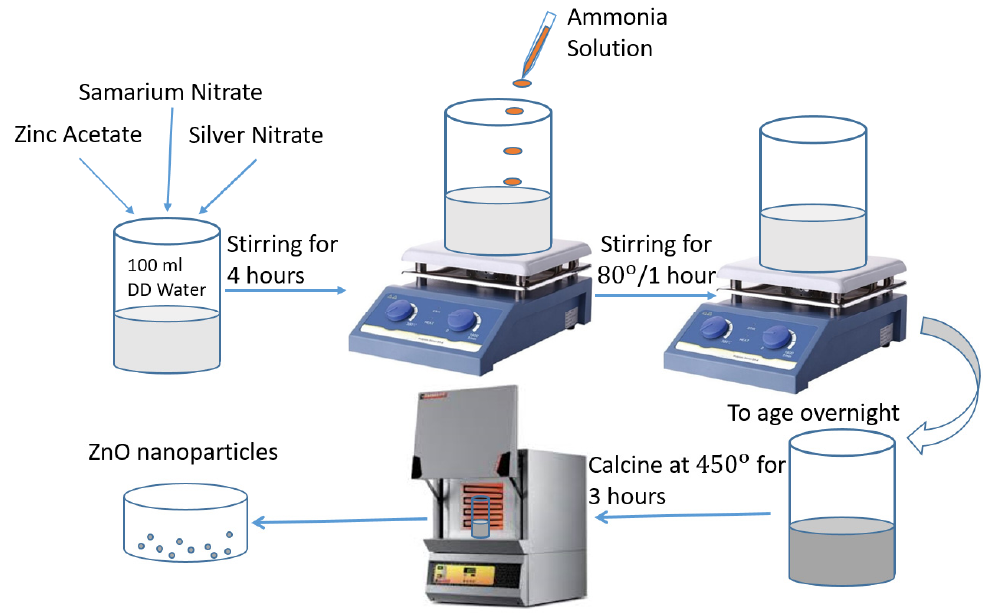
Figure 1. Schematic preparation of Au (0.0, 0.5, 1.0 and 1.5 wt %)-doped ZnO–Sm nanoparticles.